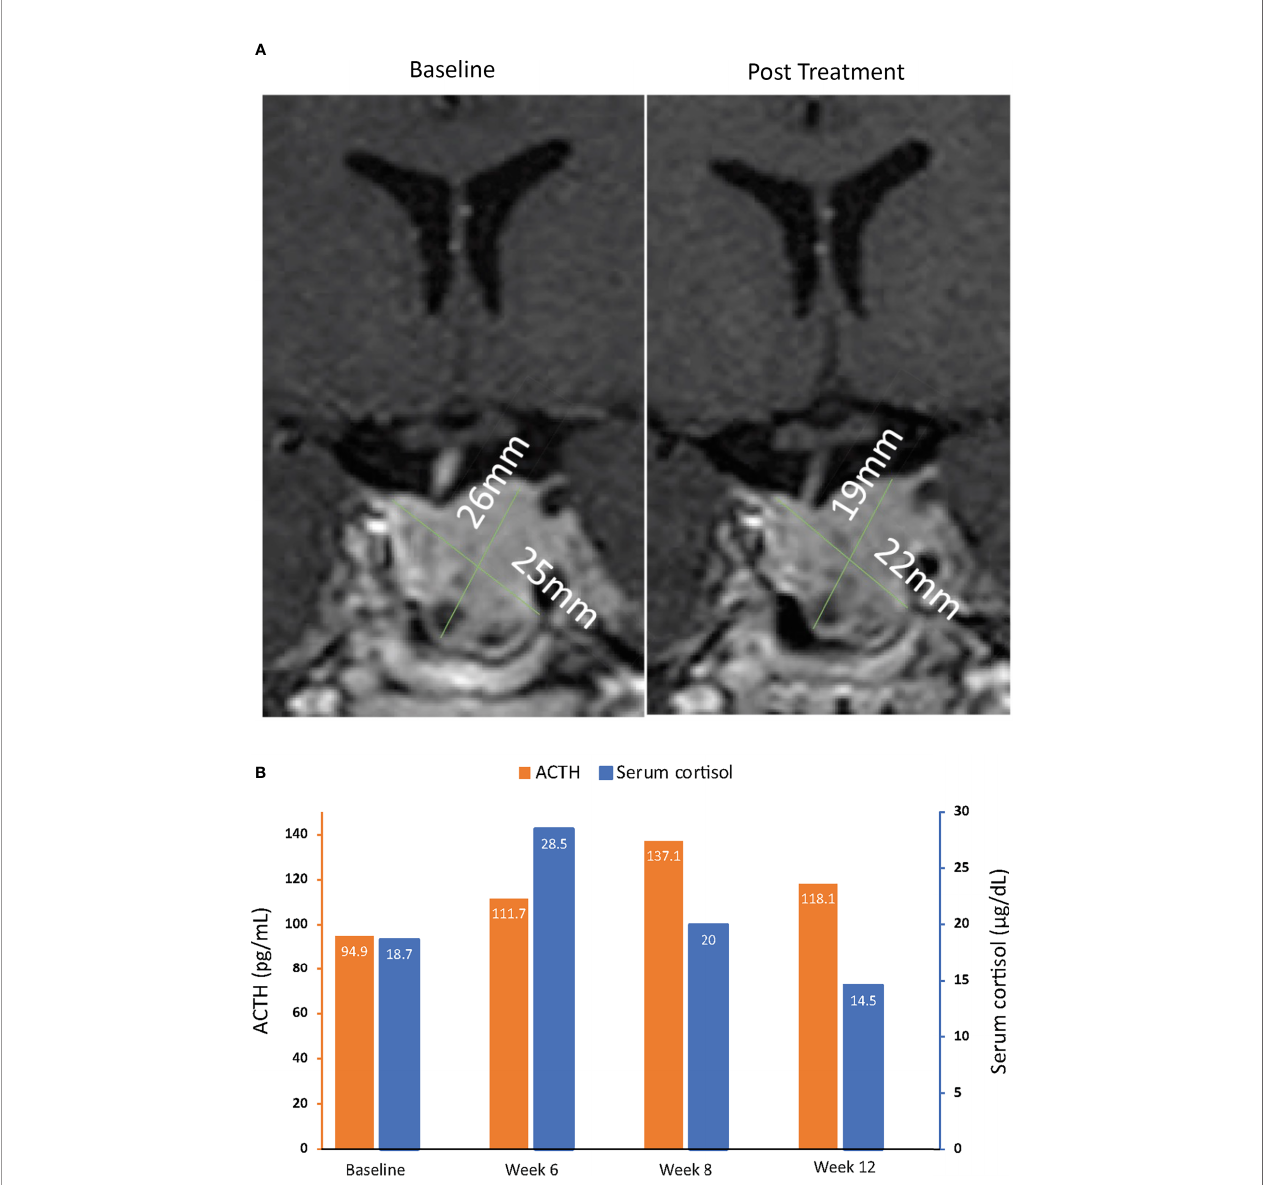
FIGURE 6 | MRI of pituitary macroadenomas (A) and ACTH and cortisol levels (B) in case 4: a 43-year-old man with Cushing disease treated with relacorilant for 12 weeks. (A) Coronal post contrast T1-weighted MRI obtained at diagnosis (left image) after administration of gadolinium showed a pituitary macroadenoma measuring 22 × 25 × 26 mm with suprasellar extension, right displacement of the pituitary stalk, and invasion of the left cavernous sinus. The tumor was isointense to the gray matter and slightly inhomogeneous for the presence of cystic changes in its lower aspect. MRI of the hypophysis obtained within 12 weeks after the last dose of relacorilant (right image), after treatment with relacorilant, showed a reduction in the size of the macroadenoma (21 × 22 × 19 mm). (B) ACTH and cortisol levels. Normal laboratory ranges: ACTH, 6.0-50 pg/mL; serum cortisol, 4.6-20.6 µg/dL. To convert ACTH values from pg/mL to pmol/L, multiply by 0.22. To convert serum cortisol from µg/dL to nmol/L, multiply by 27.6. ACTH, adrenocorticotropic